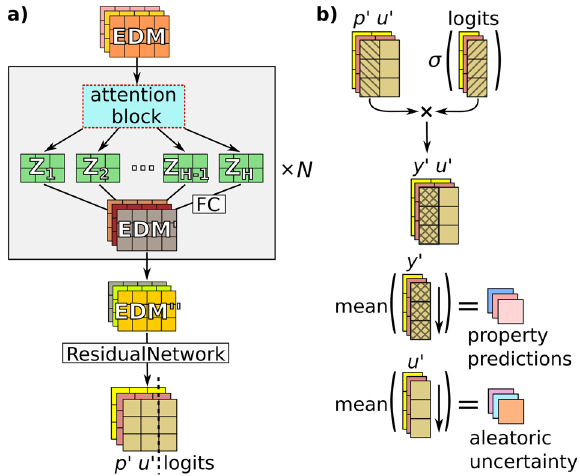
Fig. 8 Overall CrabNet architecture and prediction of material property and uncertainty. a Schematic of the CrabNet architec- ture including the input EDM , the self-attention layers (repeated N times), the updated and fi nal element representations ( EDM 0 and EDM ″ ), the residual network, and the fi nal model output. b The calculation steps for element contributions and prediction of the targets and uncertainties. The p 0 and u 0 vectors represent the element-proto-contributions and the element uncertainties, respec- tively. y 0 represent the element contributions. The material property is obtained by taking the mean of element-contributions ( y 0 ) for each compound. Similarly, the mean of the element-uncertainties ( u 0 ) gives us the estimated aleatoric